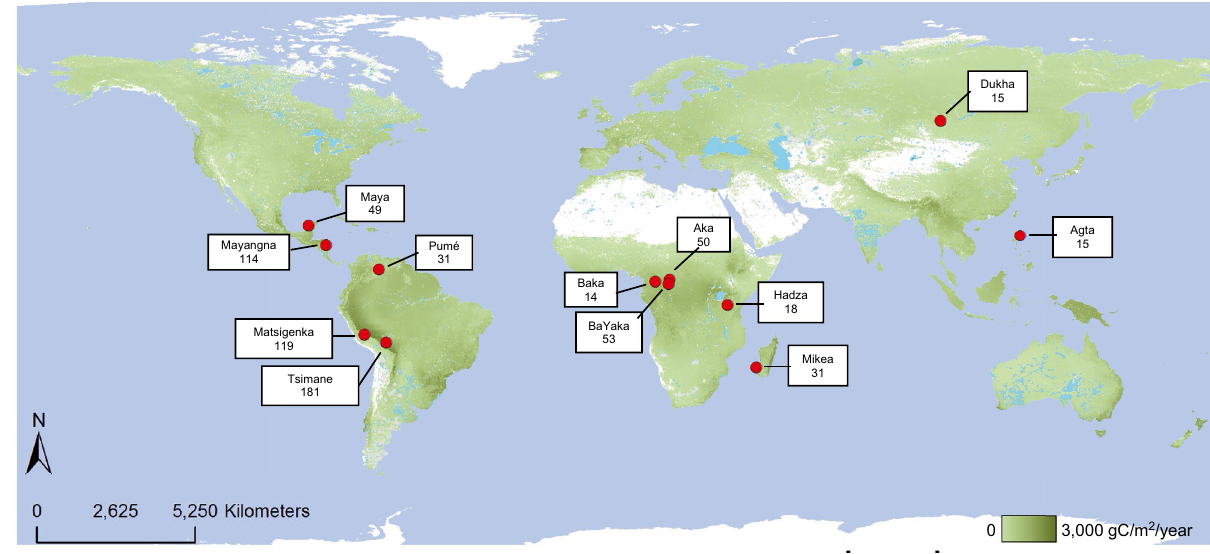
Figure 1. Map of the twelve study populations and worldwide Net Primary Productivity measured as gC/ m 2 /year (2010 data; using MOD17A3, version-55, from the Numerical Terradynamic Simulation Group at the University of Montana 81 ; map generated in ArcMap version 10.7 82 ). Environments sampled in the present analysis ranged from rainforests to savannas. The resolution is 1 km. Sample sizes for each population are provided in the box ( N =